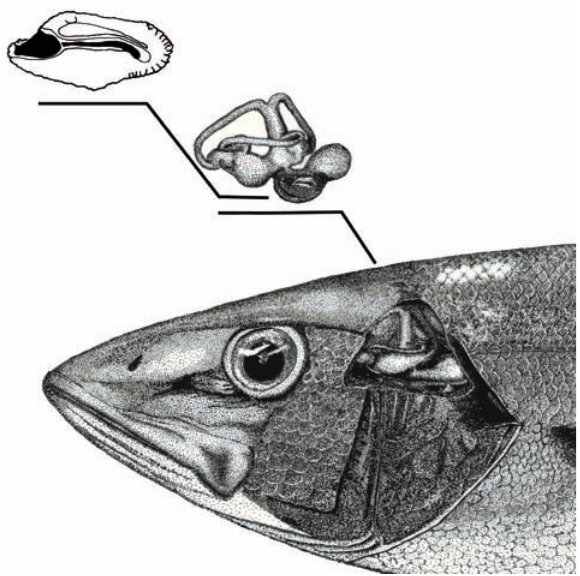
Fig. 1. – Localization the sagittal otolith in bony fish. Drawing by Nuno Miranda, adapted from Assis (2004), with permission from the Câmara Municipal de Cascais of